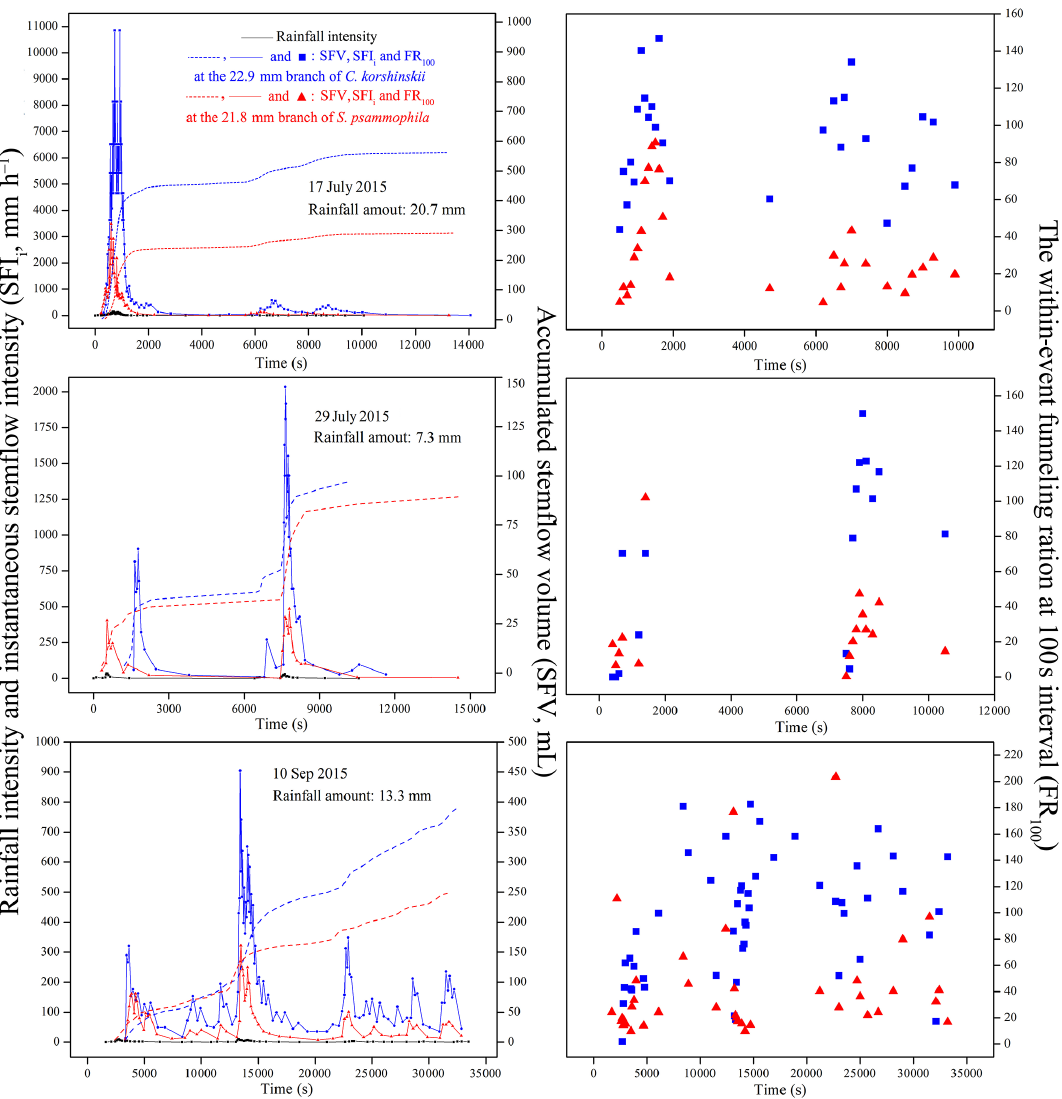
Figure 4. Stemflow synchronicity of C. korshinskii and S. psammophila to rain during representative events with different rainfall-intensity peak